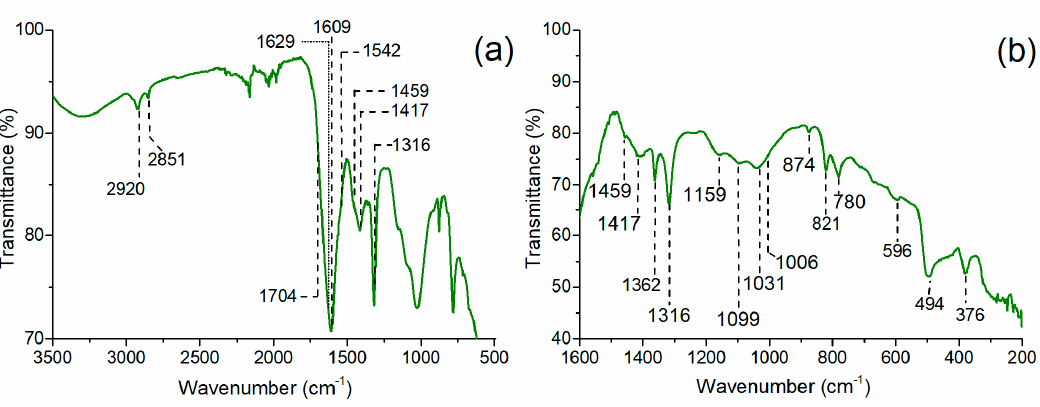
Figure 12. ATR-FTIR spectra of the green areas in the range of 3500 to 500 cm − 1 ( a ) and in the range of 1600 to 200 cm − 1 ( b ). In addition to spectral features common with gold varnish, characteristic peaks (1609, 1362, 821, 494, and 376 cm − 1 ) attributed the green pigment as verdigris (copper acetate), which, in part, was altered, which formed copper oxalates.